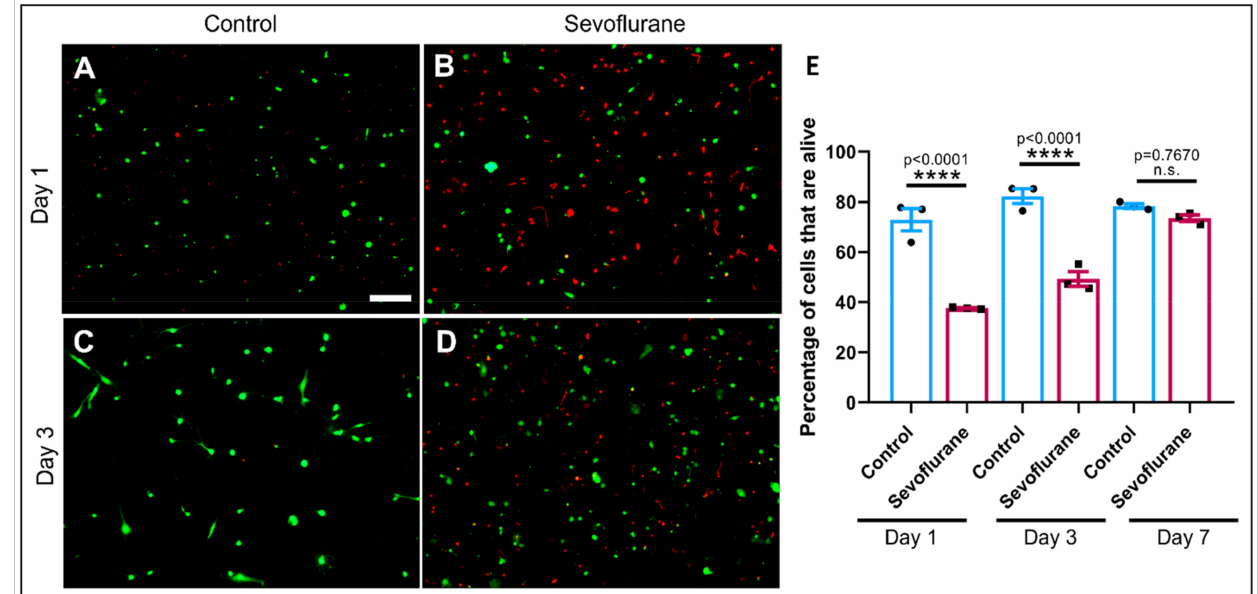
Figure 5. Sevoflurane exposure resulted in increased cell death. Representative live-fluorescent images of neuronal cultures stained with calcein-AM (green) and ethidium homodimer-1 (red) for live and dead cells, respectively. ( A ) Control cells, ( B ) cells exposed to sevoflurane 1.6% (1 h) on day 1 after sevoflurane exposure and ( C ) control cells, ( D ) cells exposed to sevoflurane 1.6% (1 h) on day 3 after sevoflurane expo- sure. Scale bar indicates 100 µ m. ( E ) Percentage of cells that are alive on day 1: Control = 72.87 ± 4.515, Sevoflurane = 37.66 ± 0.2028; day 3: Control = 82.3 ± 2.928, Sevoflurane = 49.25 ± 2.988; and day 7: Control = 78.33 ± 0.8819, Sevoflurane = 73.47 ± 1.316. Values are mean ± SEM F (5, 12) = 47.58, **** p < 0.0001 using one-way ANOVA with Dunnett’s post hoc analysis for multiple comparisons. Bars indicate ± SEM, n = 3 dishes per condition, 15–20 images per